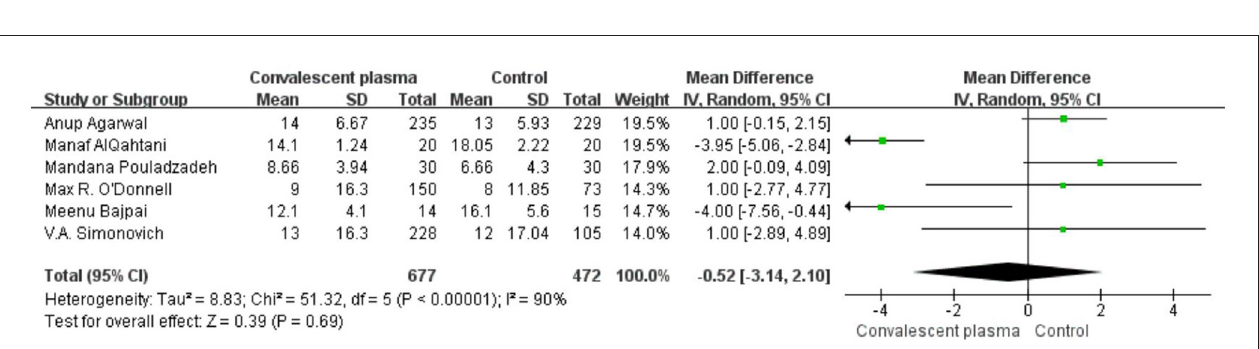
Supplementary Figures 3G,H, 4B,C, 5A,B, 6A,B, 7A,B, 8A,B , 9A,B